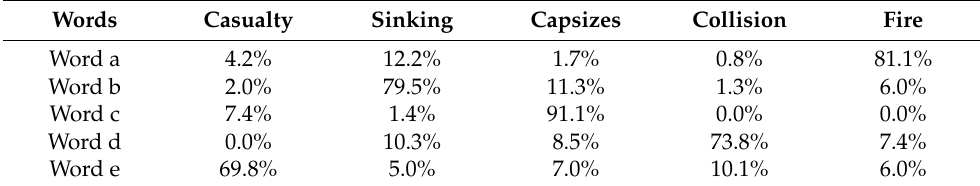
Table 3. Example of word